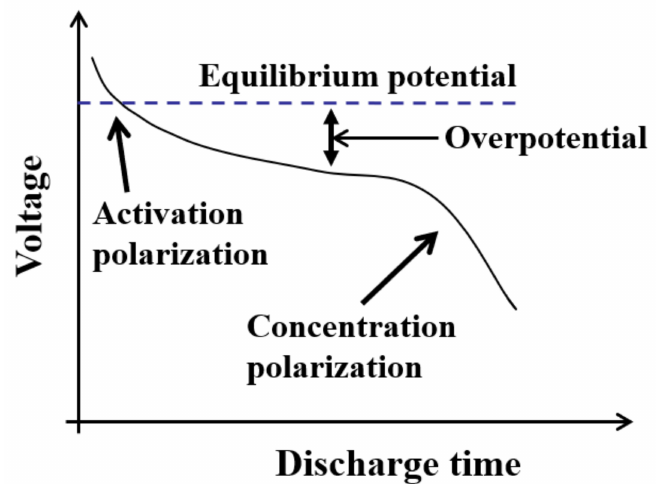
Figure 2. A typical discharge curve of a solid-state